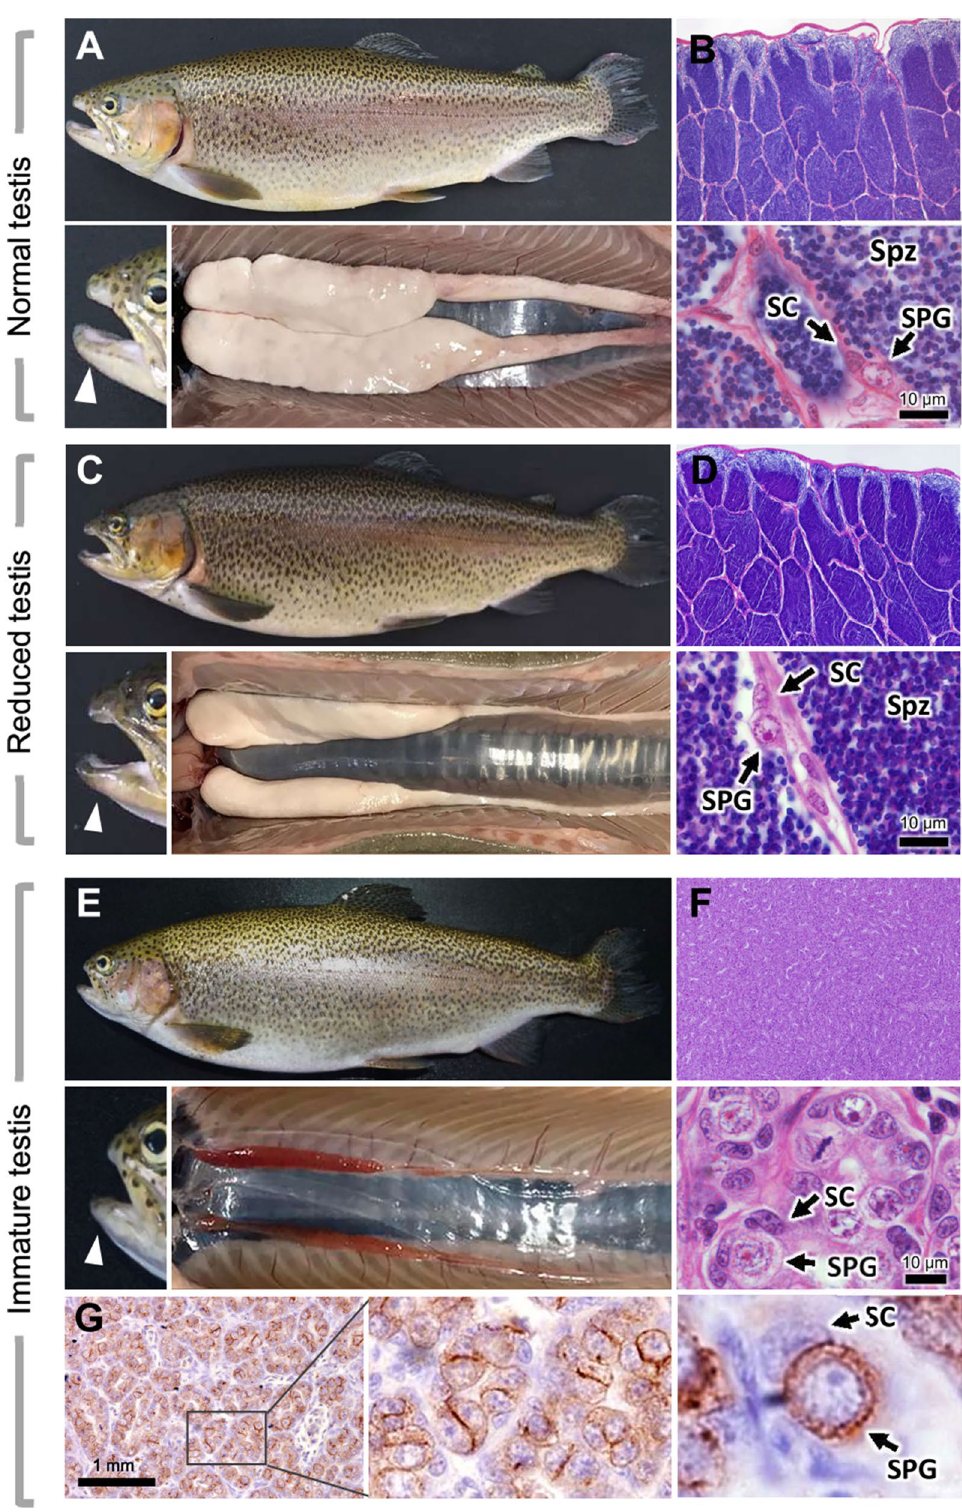
Figure 3. External body appearance and morpho-histological analysis of gonads in warm and control temperature males. ( A , B ) Adult trout with typical male phenotype presenting a hook-like jaw, a large whitish testis with abundant spermatozoa; spermatogonia and Sertoli cells are also present. ( C , D ) Adult trout with typical male phenotype as in ( A ), but with a smaller testis; testis histology presents similar aspect to ( B ). ( E , F ) Adult trout without male-specific secondary sexual characteristics, presenting a thin, reddish gonad, without spermatozoa; most germ cells are spermatogonia. SPG: spermatogonia; CS: Sertoli cells; Spz: spermatozoa. Arrowheads indicate the jaw, which has a hook-like morphology in A and C (mature males), but not in E (immature male). ( G ) Immunohistochemical detection of undifferentiated spermatogonia in immature testis with a cell surface